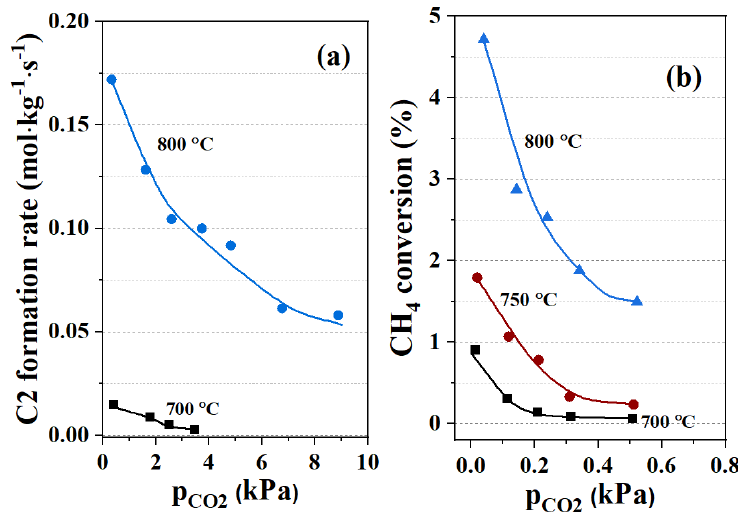
Figure 13. ( a ): Effect of CO 2 partial pressure on C2 formation rates over a La 2 O 3 /CaO catalyst at 700 ( ■ ) and 800 °C ( ● ) (p CH4 , p O2 and p N2 equal to 51, 7.3 and 42.7 kPa, respectively) [92]. ( b ): Effect of CO 2 partial pressure on CH 4 conversion at 700 ( ■ ), 750 ( ● ) and 800 °C ( ▲ ) over Li/MgO catalyst with p CH4 , p O2 and p tot equal to 0.2, 0.01 and 1 atm, respectively [102]. Continuous lines are for visualisation only.